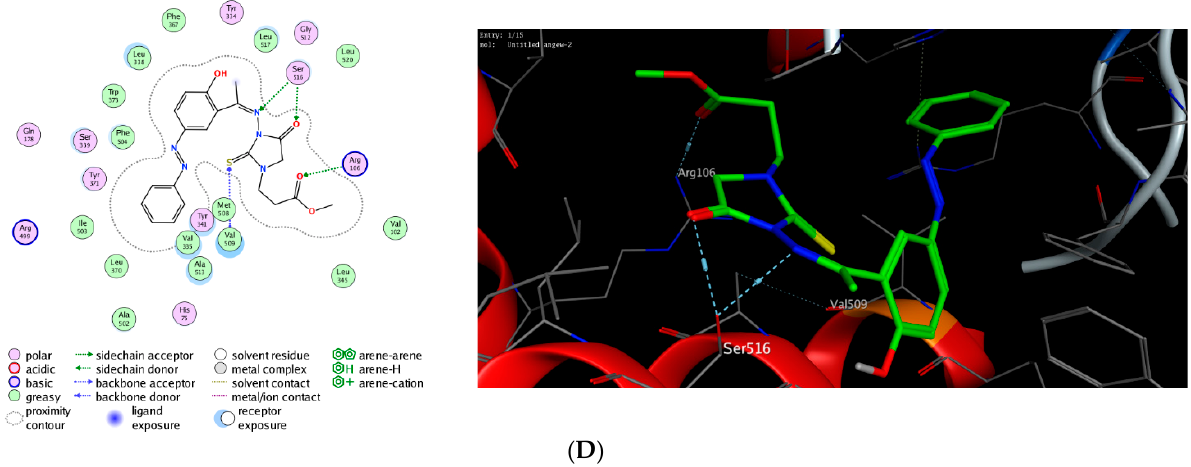
Figure 9. Interactions (2D and 3D) of compound 5 ( A , C ), and compound 7 ( B , D ) into the binding site of COX-1 (PDB code: 3kk6 ) and COX-2 (PDB code: 3ln1 ) proteins.